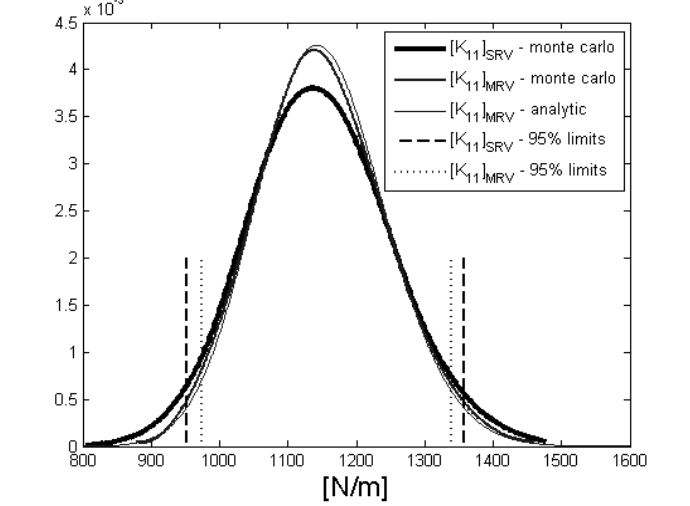
Fig. 7. Density functions of the first entry of matrix [ K ]